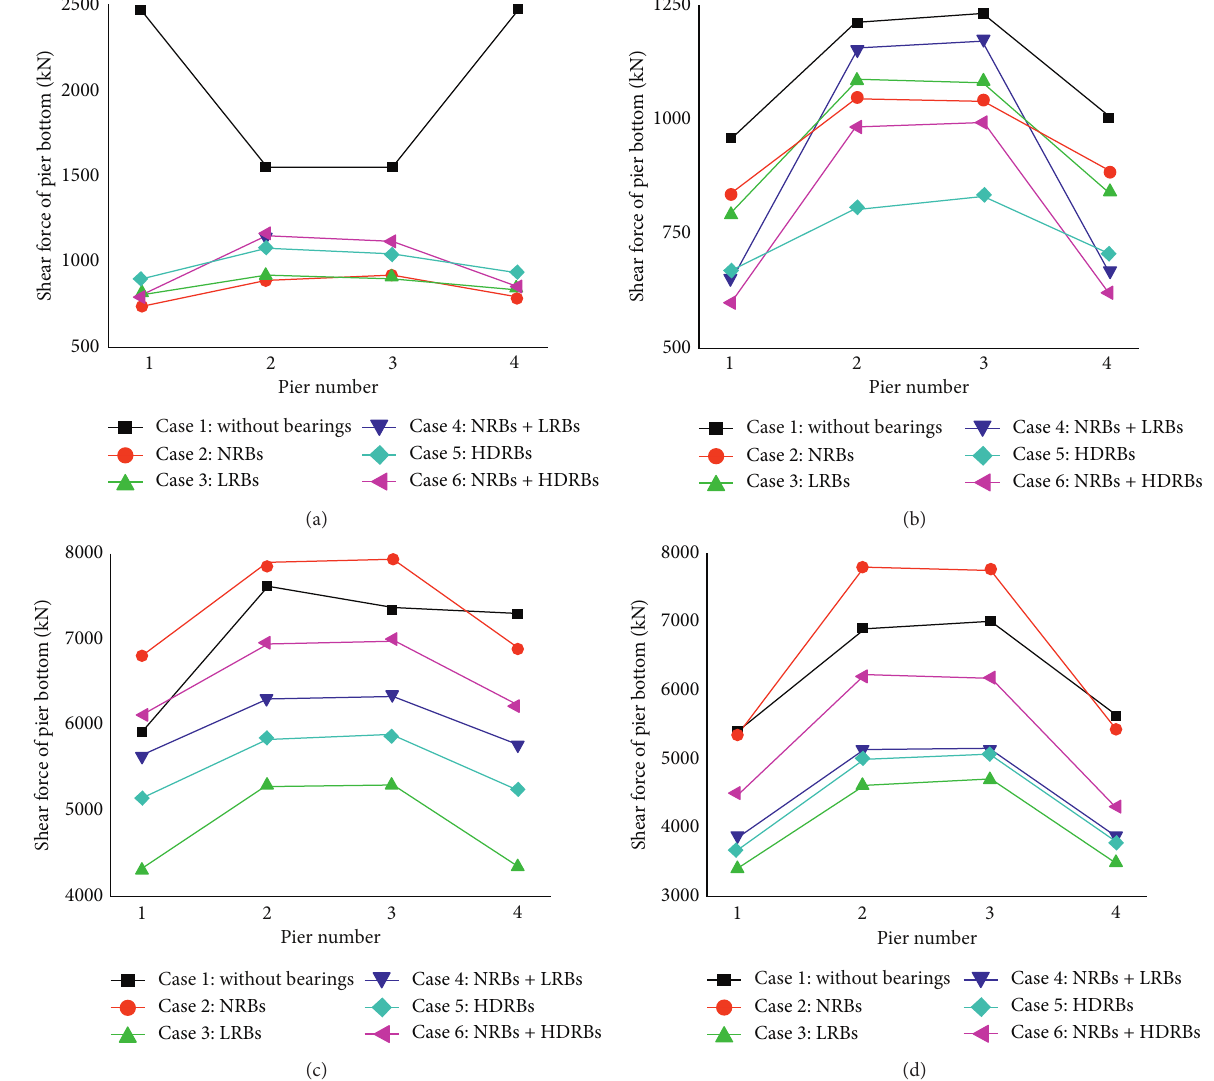
Figure 11: Shear force of the bottom of the piers in different cases: (a) longitudinal shear force under the action of small earthquake; (b) lateral shear force under the action of small earthquake; (c) longitudinal shear force under the action of large earthquake; (d) lateral shear force under the action of large